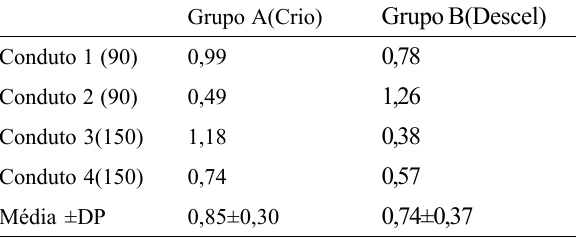
A Figura 3 ilustra alguns aspectos histológicos encontrados em homoenxertos criopreservados.